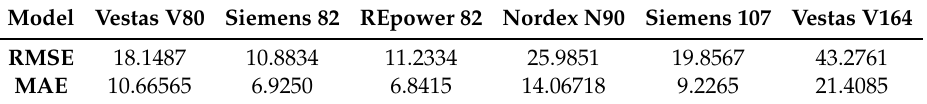
Table 6. Comparison of the RMSE and MAE values for the best case